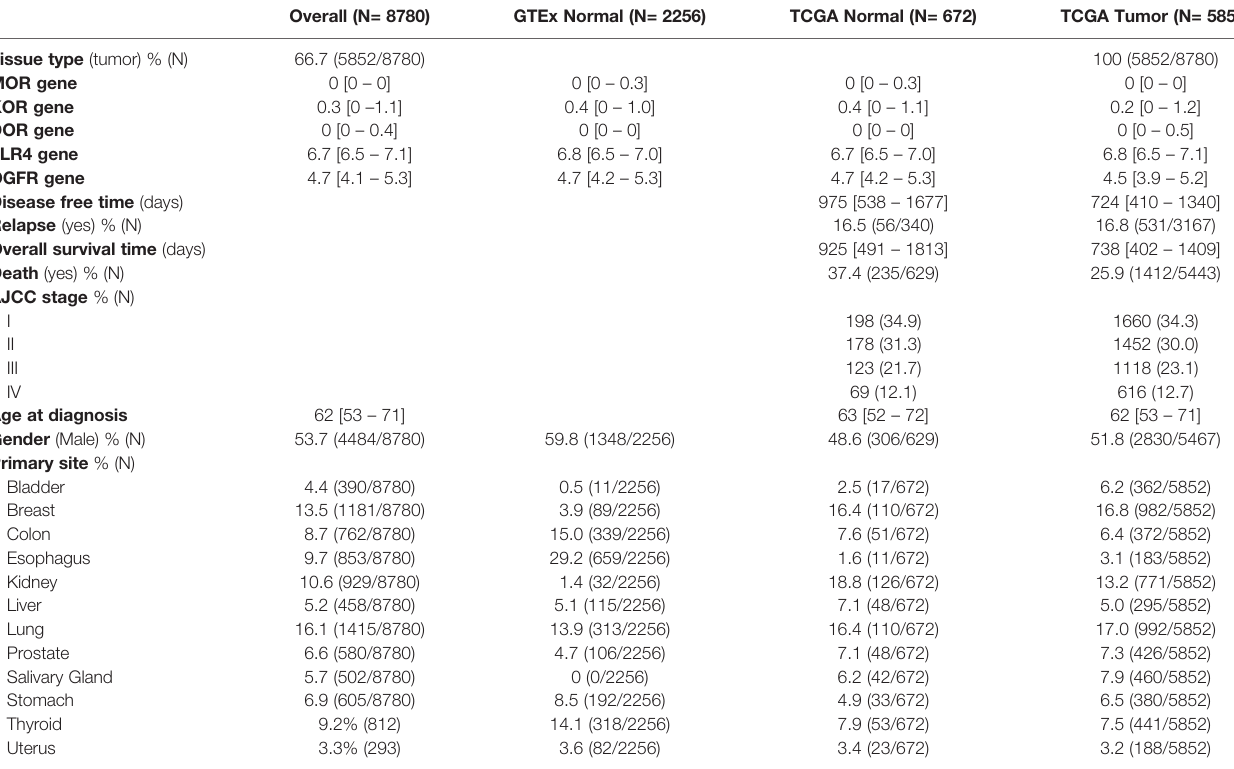
TABLE 1 | Clinical and tumor